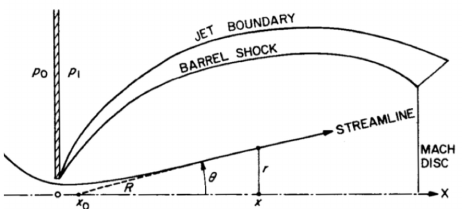
Figure 8. Geometrical parameters of a supersonic jet [23].